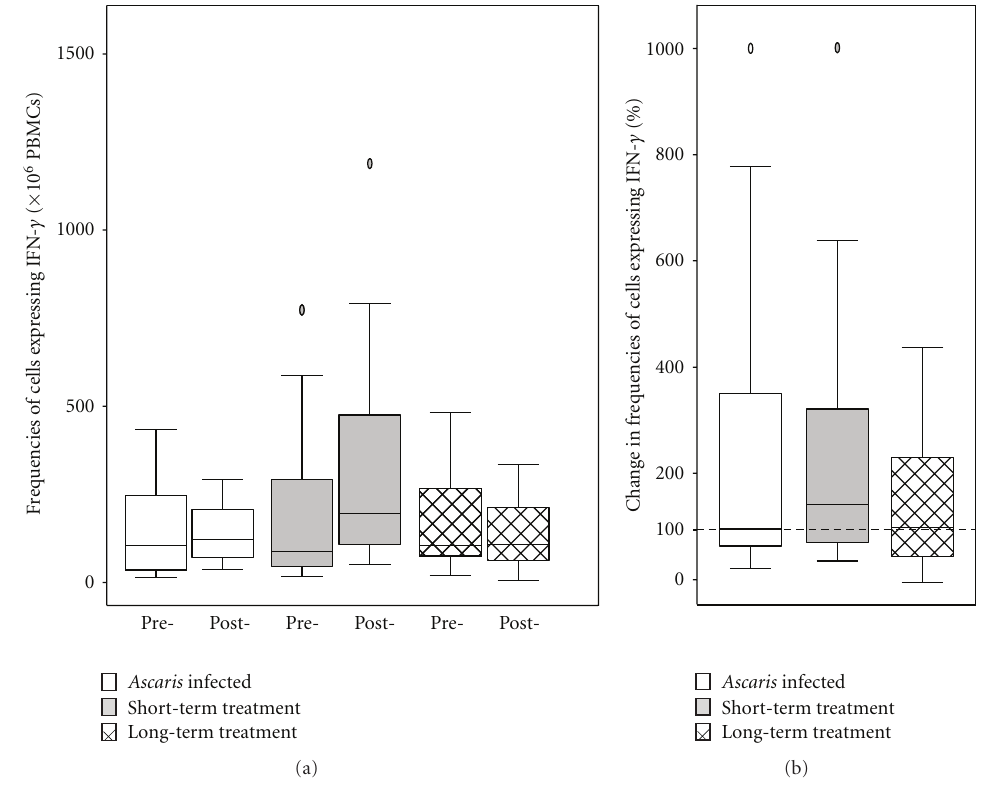
Figure 2: Frequencies of PPD-stimulated PBMCs expressing IFN- γ before and after vaccination with oral BCG Moreau. Frequencies were measured by ELISPOT. Graphs are (a) frequencies of PBMCs before (pre-) and after (post-)vaccination in active infection (clear), short- term anthelmintic treatment (grey), and long-term anthelmintic treatment (hatched) study groups; (b) percent changes in frequencies postvaccination compared to prevaccination. 100% shows no change. Shown are box plots with median (central line), interquartile range (box margins), 95% confidence intervals (bars), and outlying values